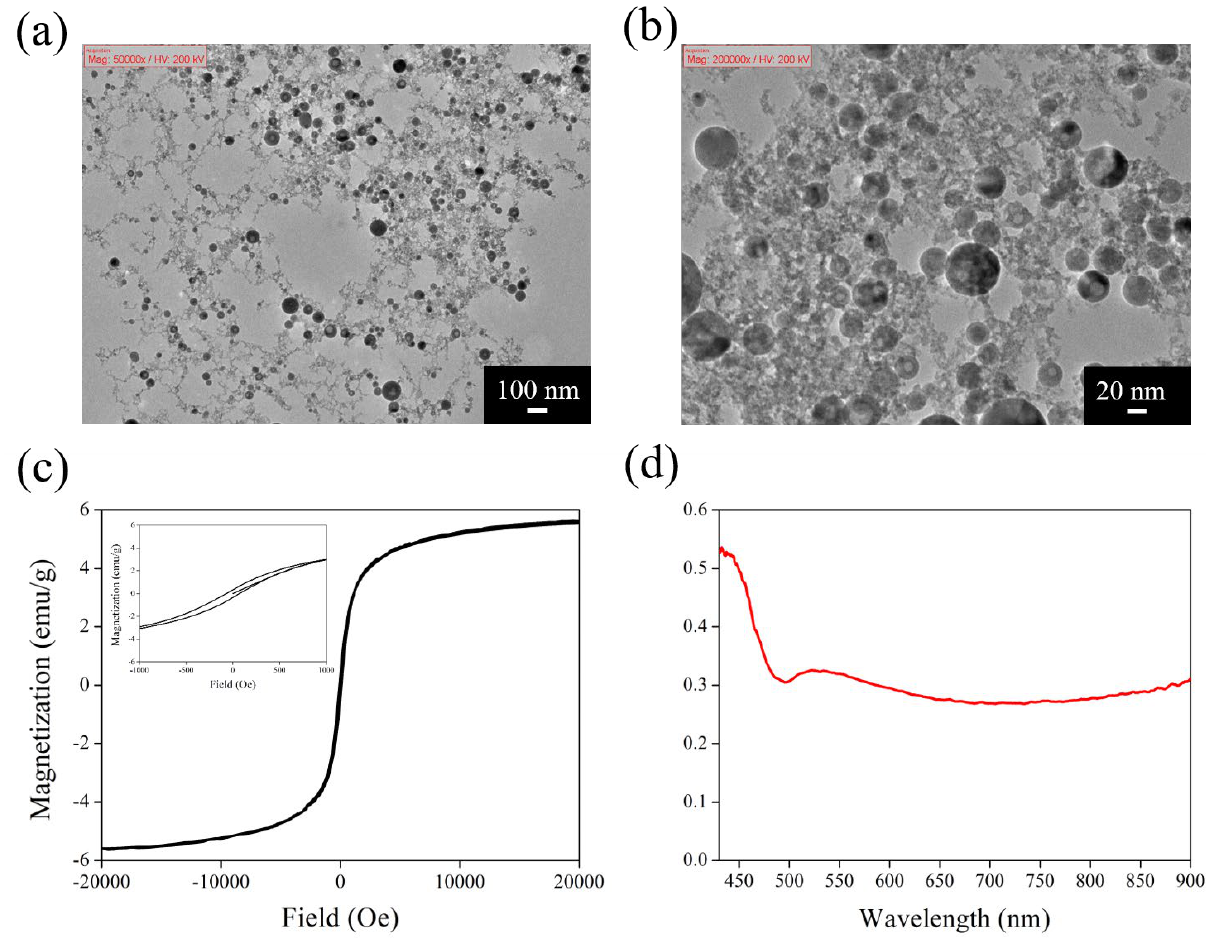
Figure 5. TEM images ( a , b ), ( c ) magnetization curve, and ( d ) absorption spectrum of magnetic Fe 3 O 4 NPs synthesized by PLIP method using ferrocene as precursor. NPs synthesized by PLIP method using ferrocene as